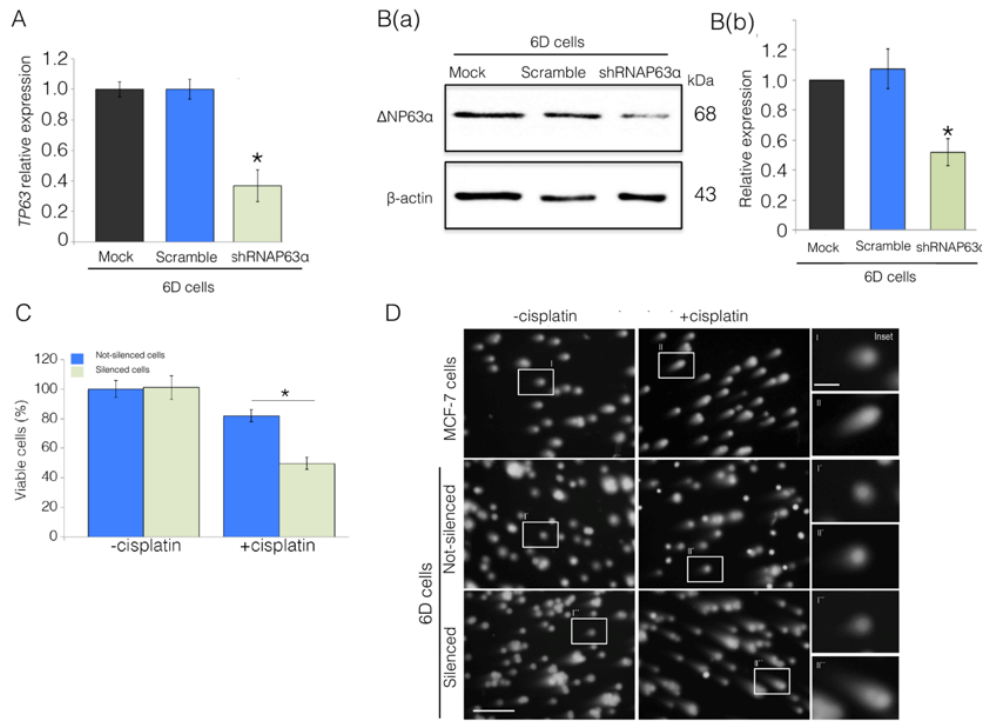
Figure 2. ∆ Np63 α plays a role in the IL-1 β induction of cisplatin resistance in 6D cells. Cells were transfected with empty vector (Mock), non-specific short hairpin RNA (Scramble), and the specific silencing RNA (shRNAp63 α ). ( A ) TP63 expression was evaluated by qPCR. Results represent the average of three independent experiments ± SD. Asterisks correspond to p = 0.001 relative to the controls, Mock and Scramble. ( B (a)) Representative Western blot of ∆ Np63 α protein levels in the 6D cells. ( B (b)) Densitometric values corresponding to ∆ Np63 α levels in ( B (a)) were normalized to those of β -actin. ( C ) Cell viability levels determined in ∆ Np63 α -silenced and non-silenced cells in the absence or presence of cisplatin. Data represent the average of four independent experiments ± SD. Asterisks indicate significance relative to 6D cells at p = 0.001. ( D ) Comet assay to evaluate DNA integrity and damage by cisplatin in MCF-7, non-silenced, and shRNAp63 α -silenced 6D cells. Cells not treated and treated with cisplatin were mixed with low-melting point agarose, lysed, and subjected to electrophoresis, followed by staining with ethidium bromide. DNA was visualized by fluorescence microscopy; scale bar = 100 µ m. The insets in the right panel show magnified images taken from each condition; scale bar = 25 µ